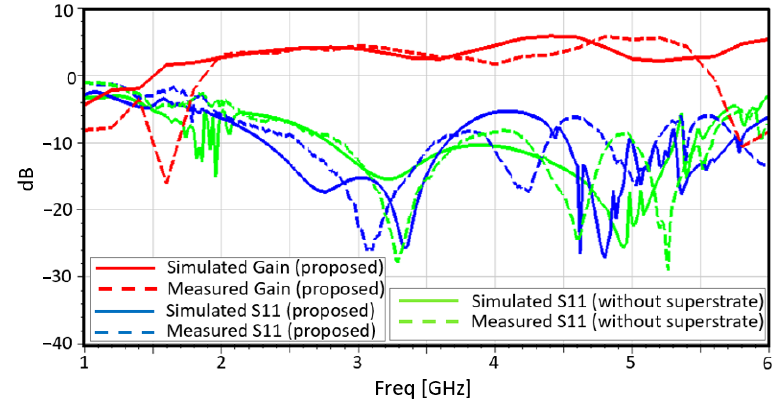
Figure 19. Reflection coefficient and gain of the fabricated prototype of the proposed antenna 2.